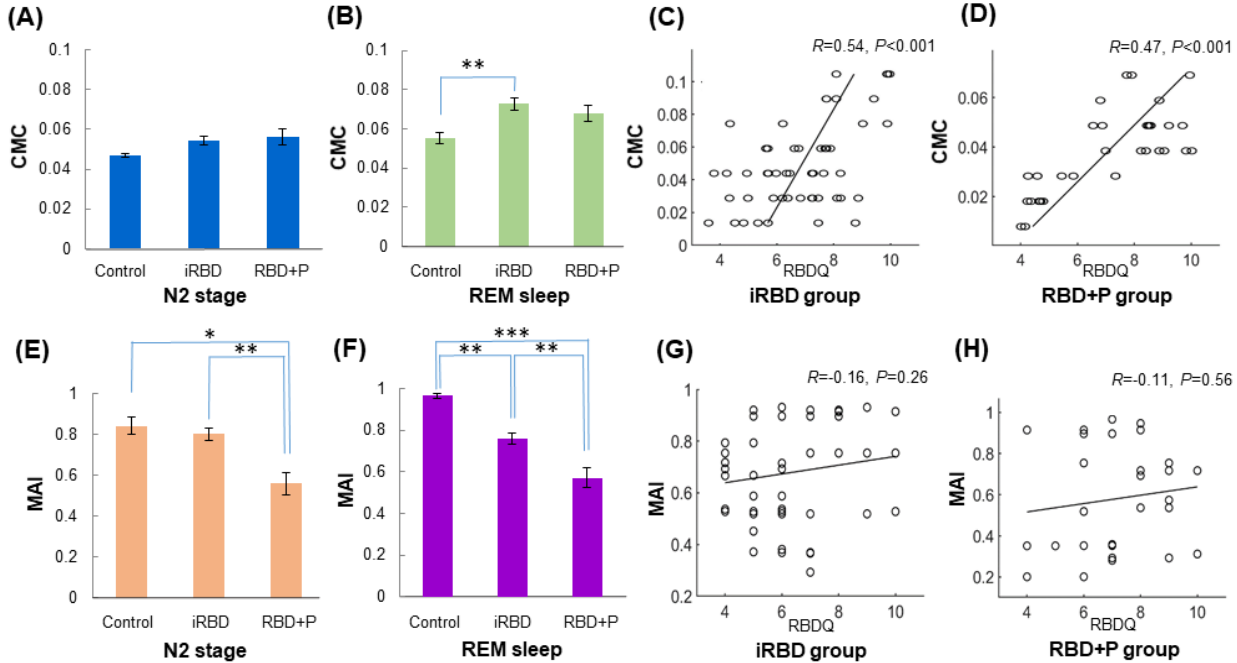
Figure 1. The corticomuscular coherence (CMC) and muscle atonia index (MAI) in control, iRBD, and RBD+P groups, with correlation between RBD severities. ( A ) CMC during NREM sleep, ( B ) CMC during REM sleep, ( C ) correlation between RBDQ scores and CMC values during REM sleep, ( D ) MAI during NREM sleep, ( E ) MAI during REM sleep, and ( F ) correlation between RBDSQ and MAI during REM sleep. Note that CMC values increased during REM sleep stage in iRBD group compared with control subjects, but was not different from those of the RBD+P group ( B ). Interestingly, the high score of RBDQ was correlated with high CMC index during REM sleep, both in iRBD and RBD+P groups, meaning that CMC index represents RBD severity ( C and D ). In addition, the MAI was significantly decreased during both NREM2 and REM sleeps in iRBD group, and even more reduced in the RBD+P group ( E , F ). However, there was no relationship between RBDQ scores and MAI in either iRBD or RBD+P groups ( G , H ). Abbreviation: CMC, corticomuscular coherence; MAI, muscle atonia index; iRBD, idiopathic RBD; RBD+P, RBD with Parkinsonism; NREM, non-rapid eye movement; REM, rapid eye movement; RBDSQ, RBD screening questionnaire; RBDQ, RBD questionnaire. Asterisks (*) means p - value < 0.05 ; ** p < 0.01, *** p < 0.001.